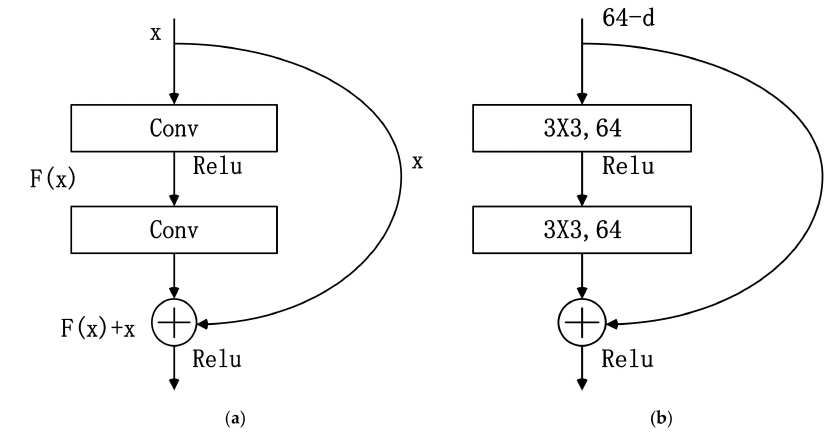
Figure 2. ( a ) Residual learning unit; ( b ) Two-layer residual learning